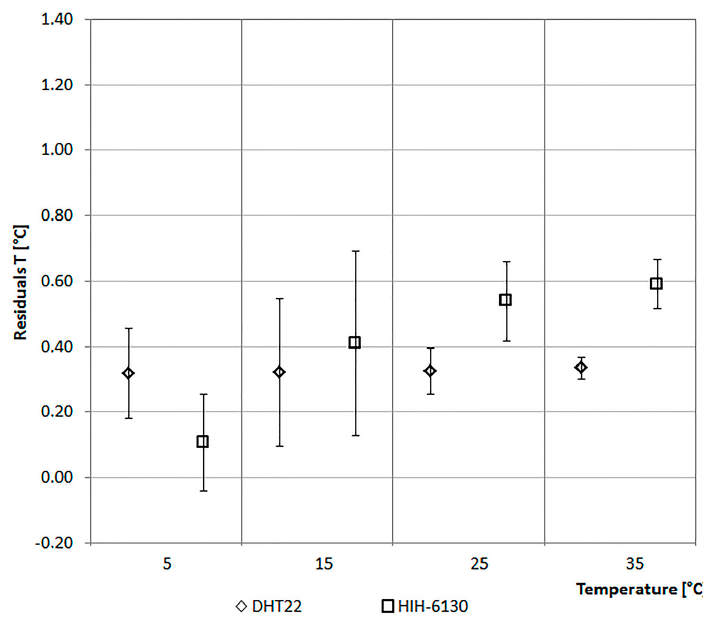
Figure 6. Air temperature data comparison.